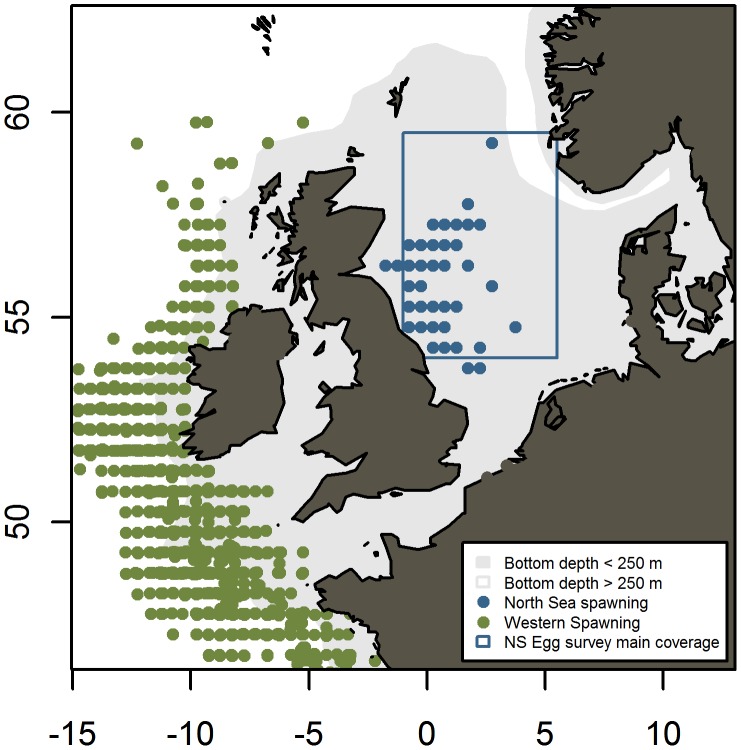
Mackerel populations and distribution around the north-western European shelf.Continental shelf marked in grey (bottom depth <250 m). North Sea and western mackerel spawning areas indicated by dots. Each dot marks an observation of 50+ eggs m−2 day−1. Data from international mackerel egg surveys (Blue = North Sea 2002–2011 [7], [34], [35], Green = Western areas 1977–2007 (ICES WGMEGS)). Blue rectangle marks the approximate main coverage of the international mackerel egg survey in the latter years [7], [34], [35].